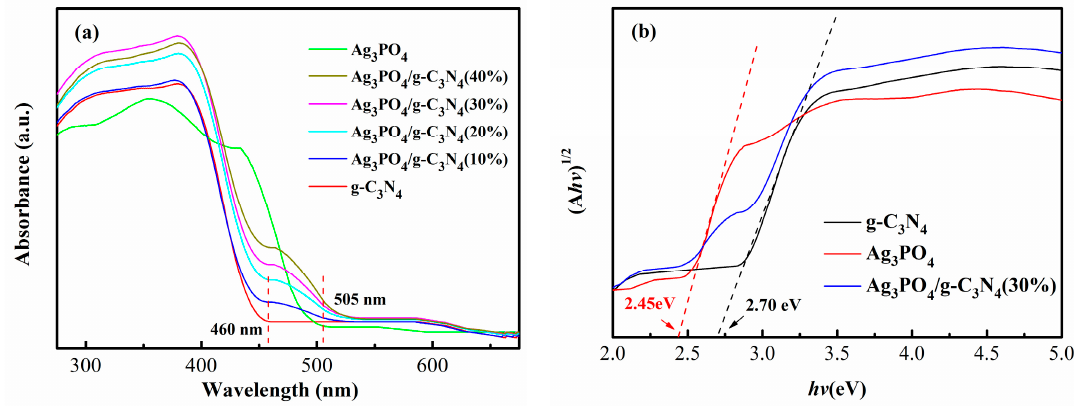
Figure 5. ( a ) UV-Vis diffused reflectance spectra of the as-prepared photocatalyst; ( b ) Plots of ( Ah ν ) 1/2 versus energy ( h ν ) for the g-C 3 N 4 and Ag 3 PO 4 /g-C 3 N 4 (30%).